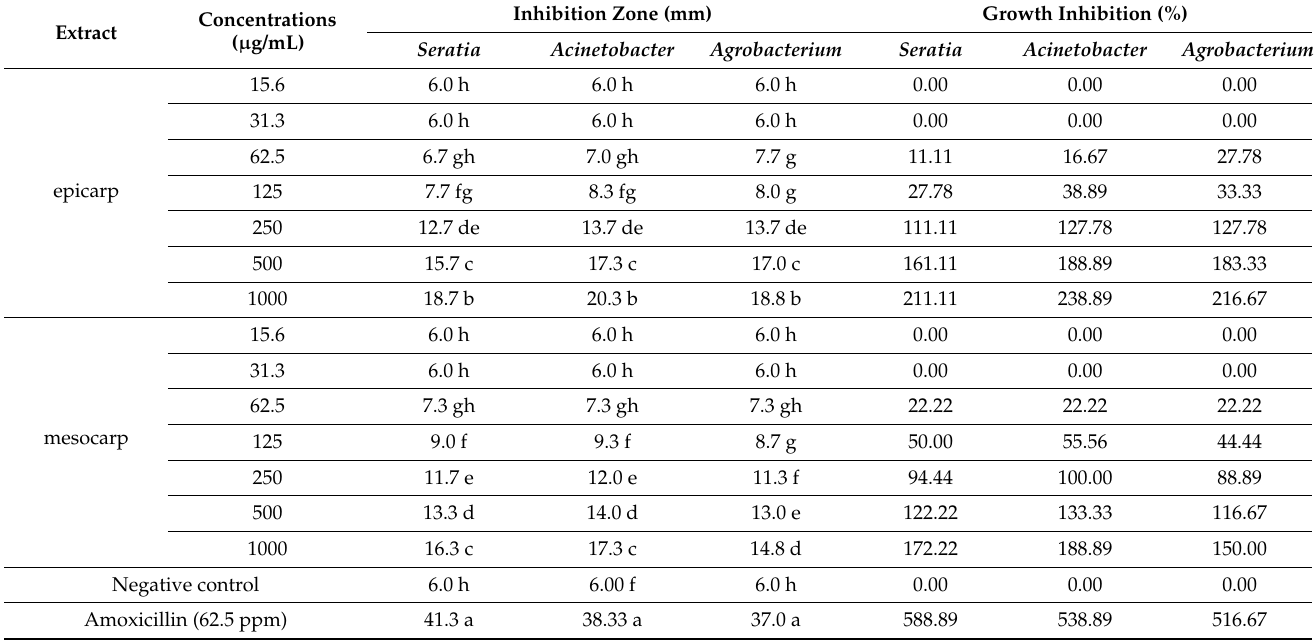
Table 4. Antibacterial activities of methanol extract of neem fruit epicarp (epicarp) against Serratia marcescens, Acinetobacter johnsonii, and Agrobacterium tumefaciens